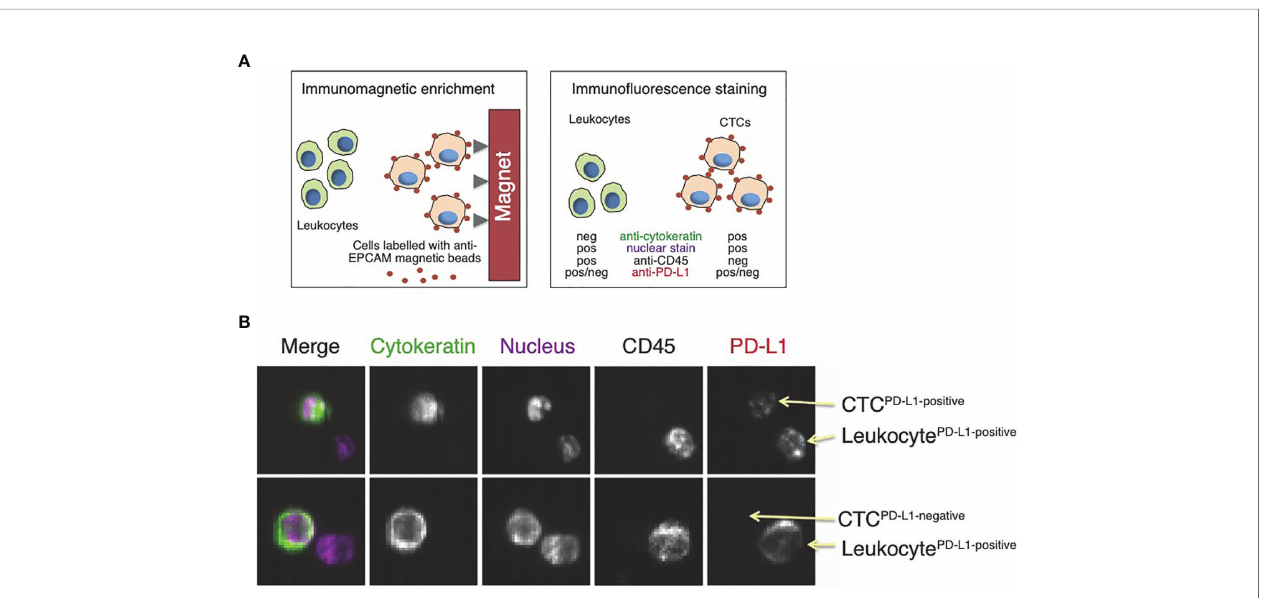
FIGURE 3 | Assessment of PD-L1 expression in circulating tumor cells (CTCs). (A) CellSearch is a semi-automated two-step system used for CTC detection. First, monoclonal antibodies against the epithelial cell adhesion marker (EPCAM)-conjugated to iron beads are added to the blood sample. Magnetic capture allows for the enrichment of tumor cells expressing EPCAM. This is followed by immuno fl uorescence staining to distinguish CTCs from leukocytes and to detect PD-L1 expression; (B) Examples of images from the CellSearch gallery to identify CTCs expressing PD-L1. Modi fi ed with permission from